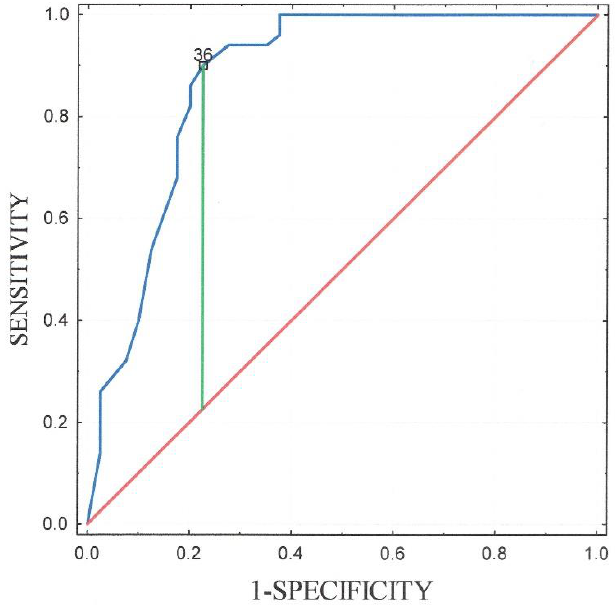
Figure 3. ROC curve of the age for the diagnosis of acute myocarditis. The AUC was 0.875 (standard error = 0.041, 95% confidence interval: 0.795–0.954). It shows that the sensitivity (90%) and specificity (77.5%) of the age is adequate in statistics.